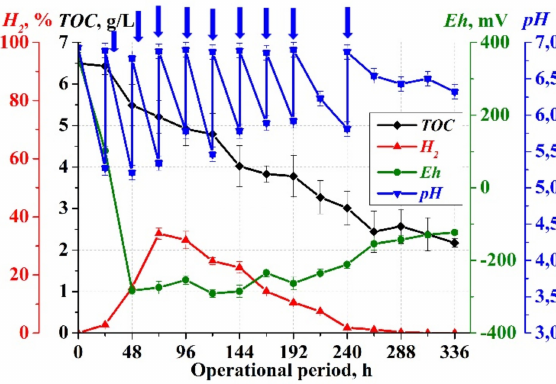
Figure 6. An effective fermentation of LFW in the presence the granular microbial preparation. Vertical arrows indicate the addition of pH